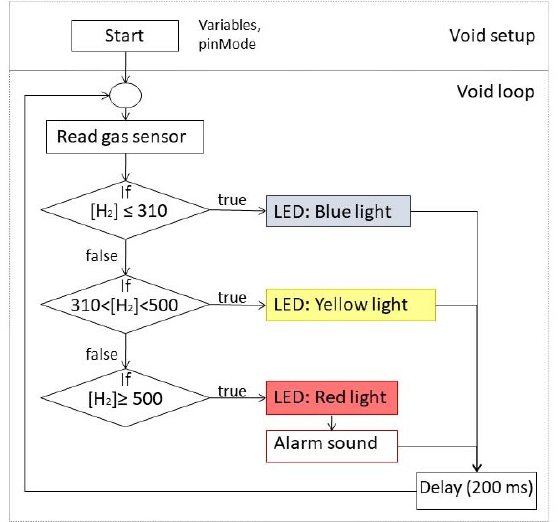
Figure 1. Flowchart of the software for the hydrogen detecting ‐ alarm